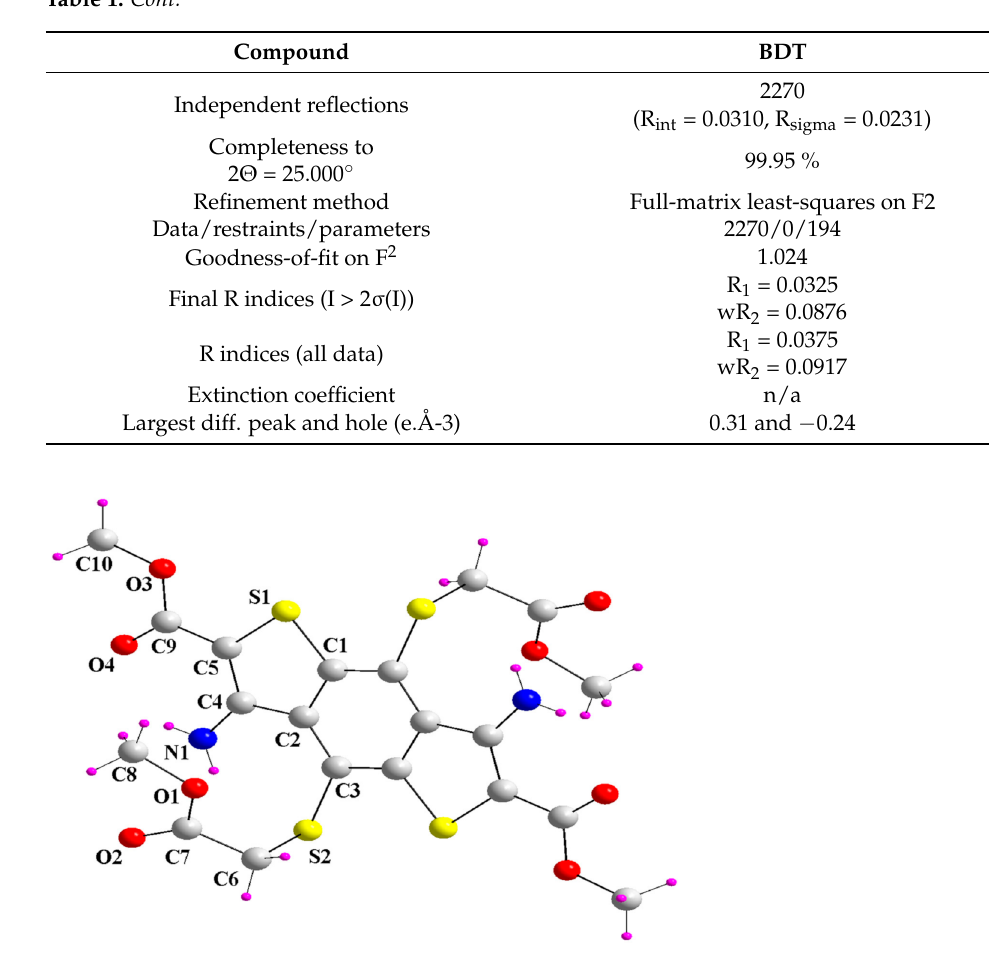
Figure 1. The molecular structure of BDT, showing the atom-labeling scheme. Displacement ellipsoids were drawn at the 30% probability